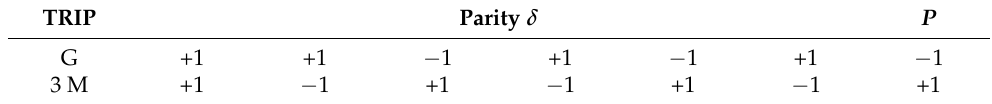
Table 3. Parities δ and their product P of spin-degenerate states at TRIPs for SbH and BiH monolayers.